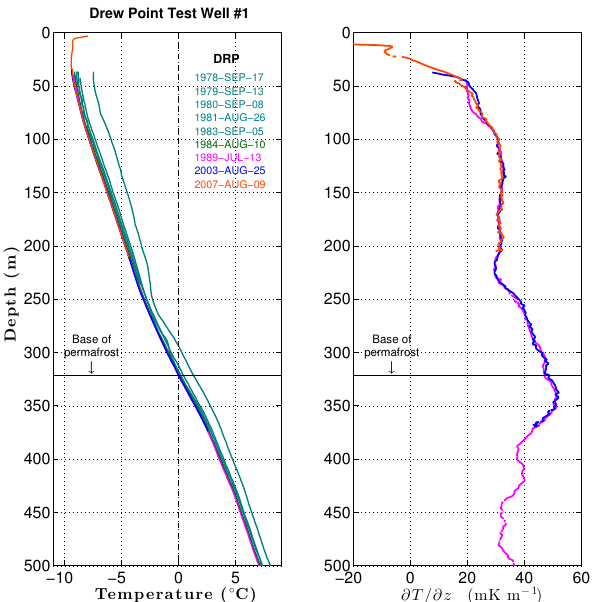
Figure 10. Temperature profiles in the Drew Point Test Well No. 1, color-coded by acquisition date (left). Temperature gradients calculated from the 1989, 2003, and 2007 logs are shown in the right panel.